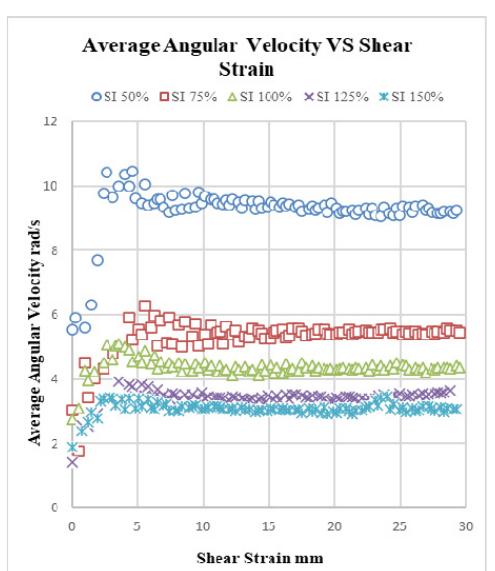
Figure 14 Average angular velocity for different size index particles under 30kPa normal